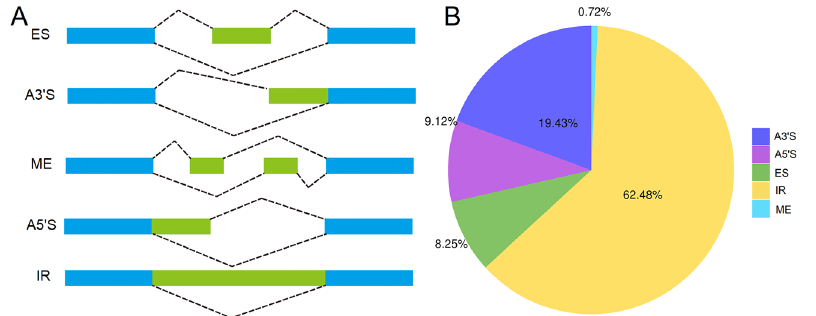
Figure 3. Overview of alternative splicing (AS) events. ( A ) Illustration of different types of AS. IR: intron retention, A3 ′ S: alternative 3’ splice site, A5 ′ S: alternative 5’ splice site, ES: exon skipping, ME: mutually exclusive exon. ( B ) Proportion of different types of AS.